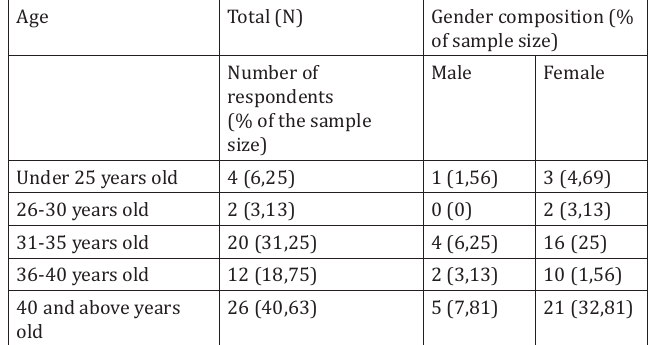
Distribution of respondents by gender and age.